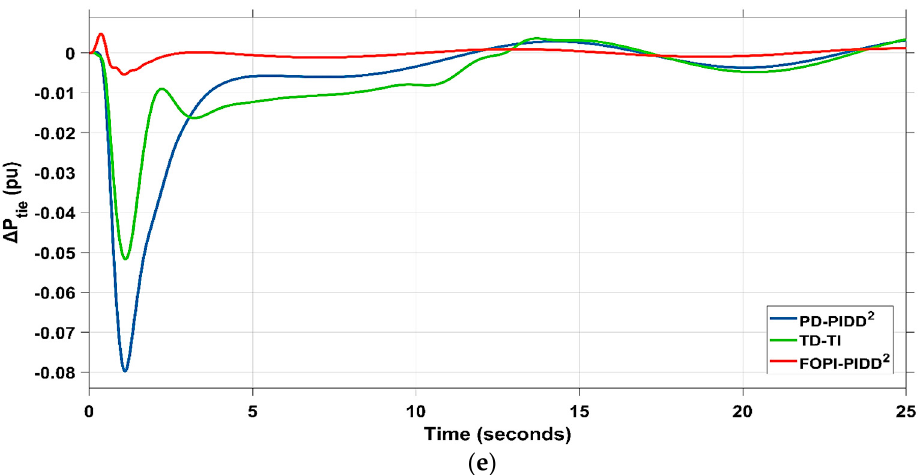
Figure 27. Assessment of PD–PIDD 2 , TD–TI, and FOPI–PIDD 2 optimized by DO algorithm for scenario 5: ( a ) V 1 , ( b ) V 2 , ( c ) Δ F 1 , ( d ) Δ F 2 , and ( e ) Δ P tie . Table 7. Dynamic speci fi cations of the investigated system represented as ITSE value using di ff erent controllers under scenario 5 impact.